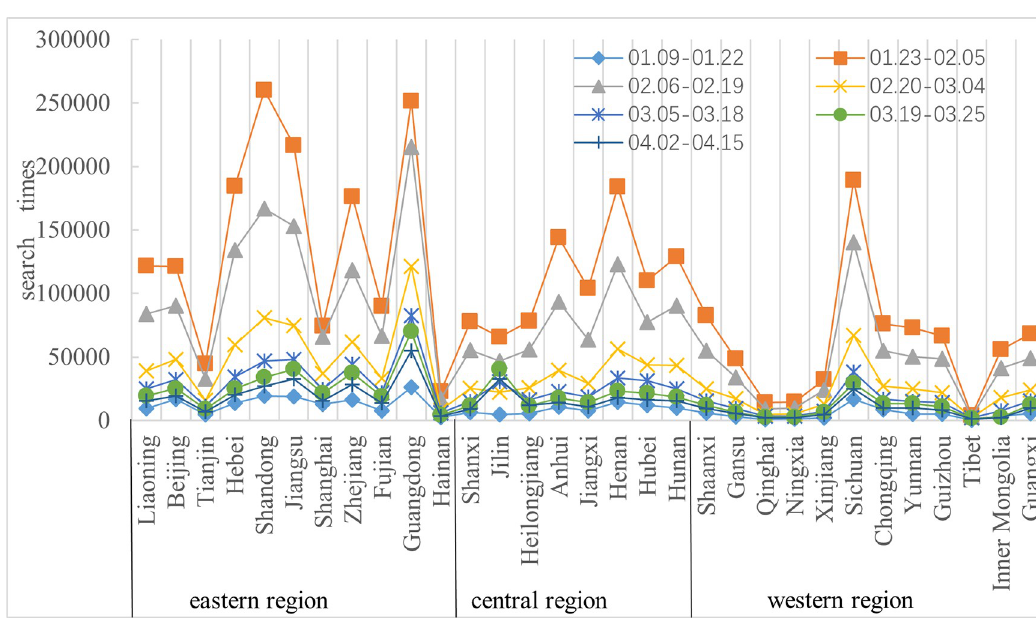
Fig 2. Change trend chart of network attention in 31 provinces.